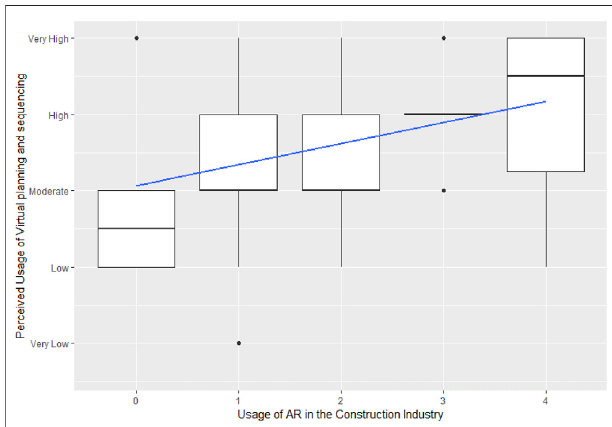
FIGURE 2 | Breakdown of the average possible use of Real-Time Visualization of Conceptual Projects among the various types of construction companies. Notes: n — represents the sample size within each group the numbers displayed on each boxplot represent